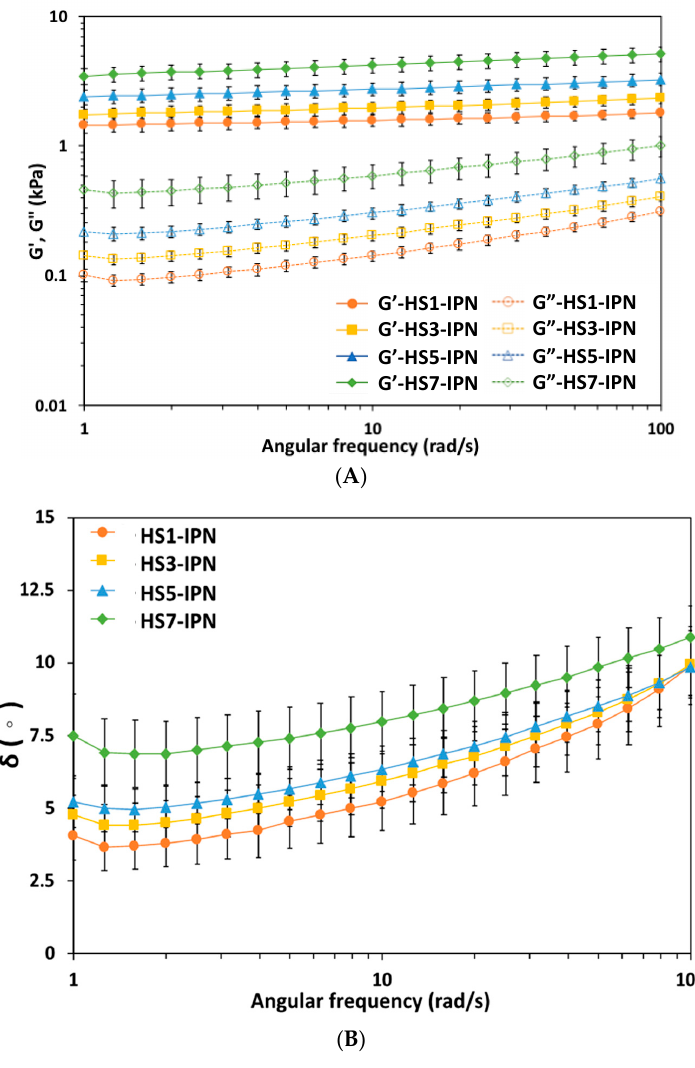
Figure 4. ( A ) The rheological parameters (e.g., G’ and G”) for all tested HS-IPN hydrogels increased with increasing the weight ratios of SF/HA in producing the hydrogels versus the varying angular frequencies, ( B ) increasing weight ratios of SF/HA in the HS-IPN hydrogels increased the δ values from about 4.2 (e.g., HS1-IPN) hydrogels to 8.0° (e.g., HS7-IPN) hydrogels vs. with varying angular frequencies, respectively (Data are mean ± SD, n = 3).